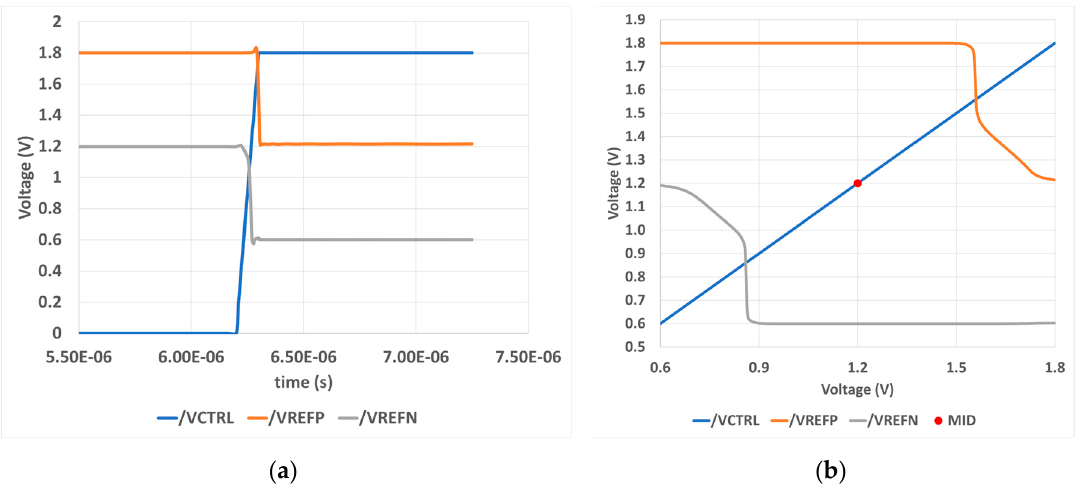
Figure 11. Control circuit post-layout simulation: (a) transient analysis; (b) DC analysis.